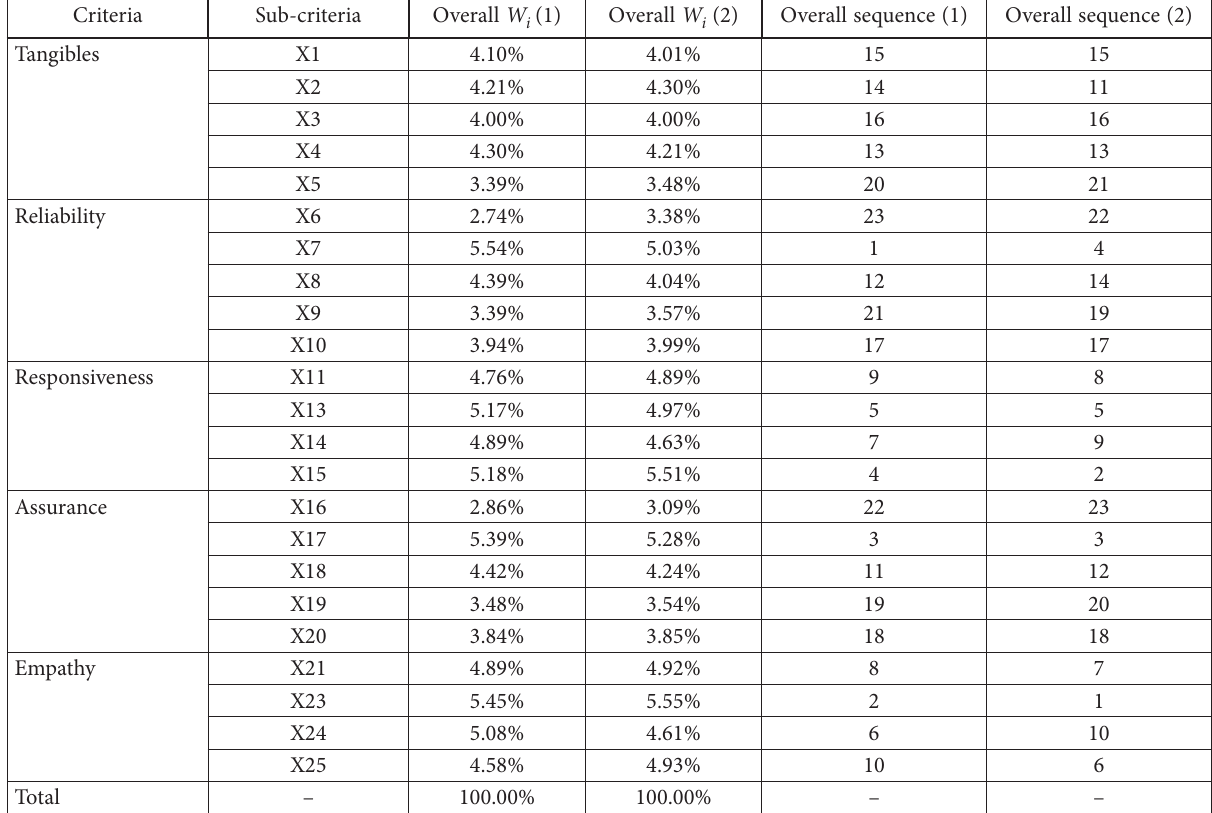
Table 5. Weight order of the AHP overall evaluation index (customer ratings)